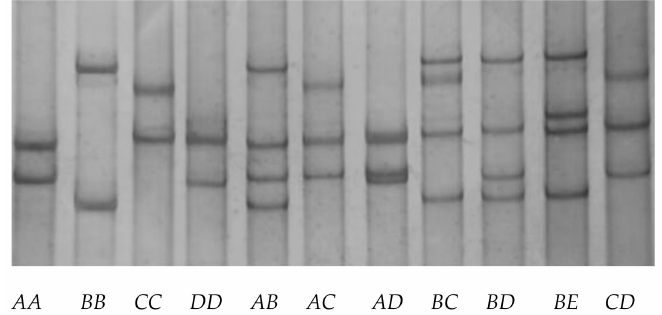
Figure 2. Representative PCR-SSCP patterns of the caprine KAP28-1 gene. Five unique